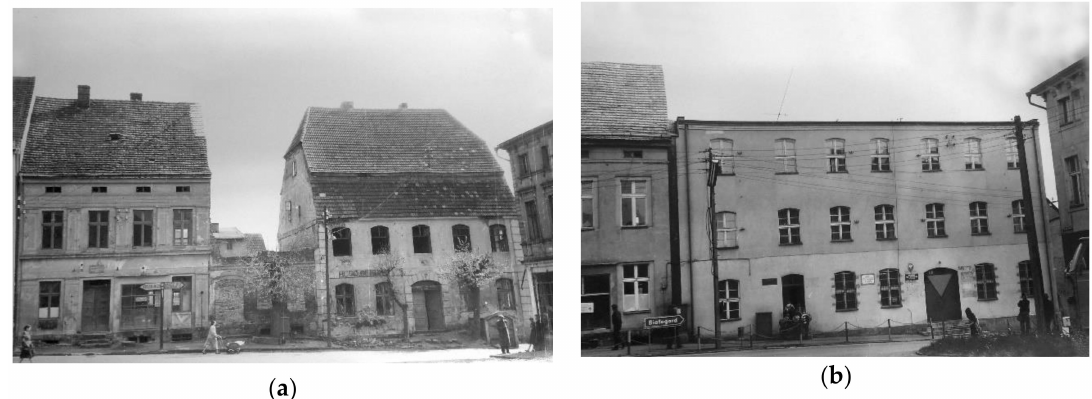
Figure 2. Archival photos: ( a ) before the reconstruction; ( b ) after the reconstruction.